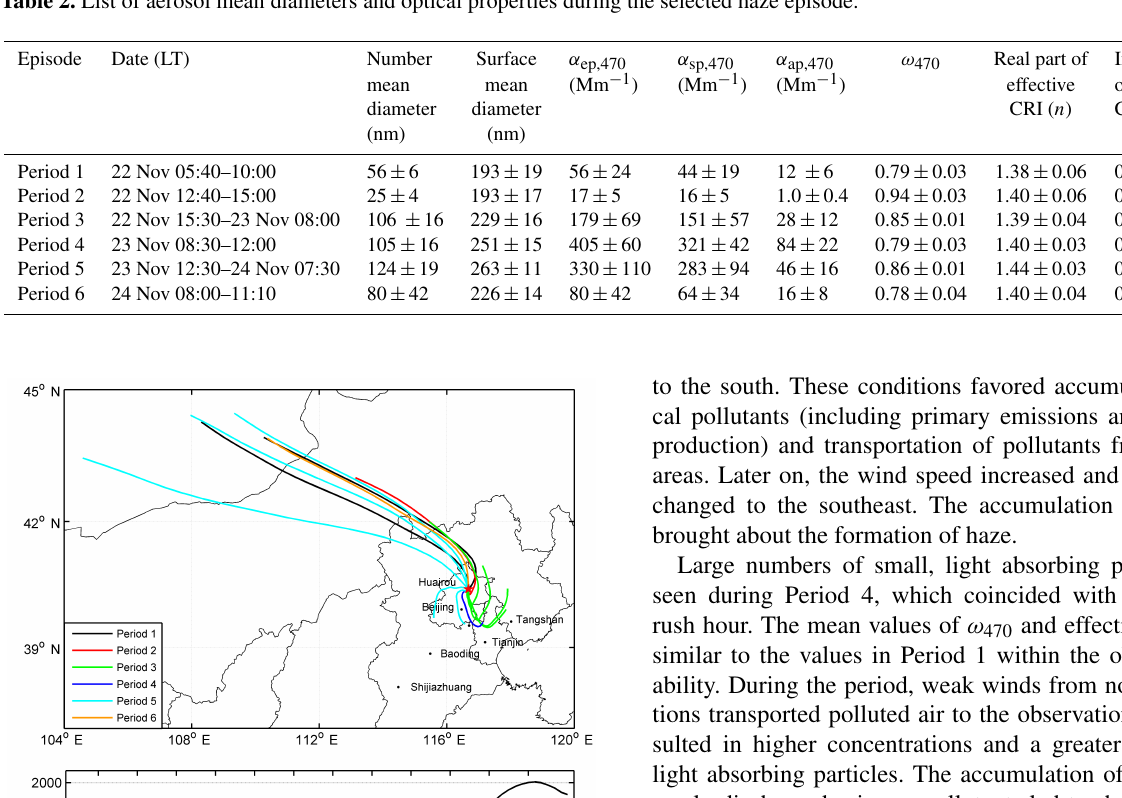
Table 2. List of aerosol mean diameters and optical properties during the selected haze episode.